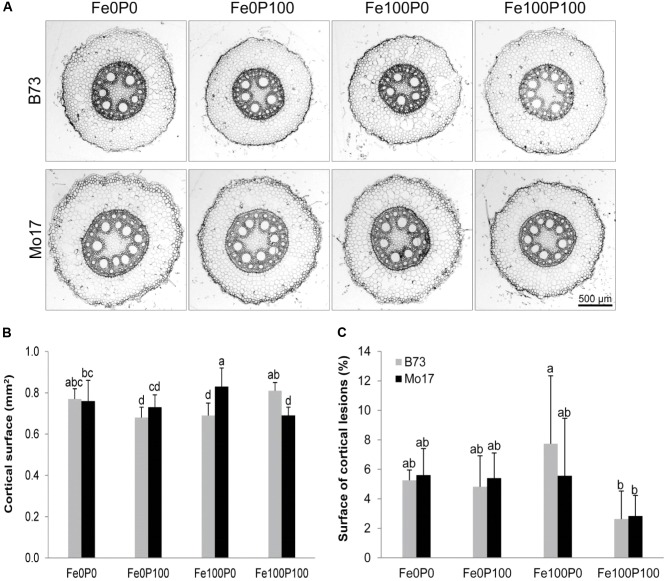
Influence of varied Fe and P nutritional regimes on root anatomy. (A) Anatomy of primary roots in cross sections, (B) cortical surface, and (C) surface of cortical lesions (expressed as proportion of lysed root tissue over the total root cross section). B73 and Mo17 plants were grown for 15 days in nutrient solution supplemented without Fe and P (Fe0P0), without Fe and with 100 μM P (Fe0P100), with 100 μM Fe and without P (Fe100P0), or with 100 μM Fe and 100 μM P (Fe100P100). Fe and P treatments were initiated after one week of preculture on full nutrient solution. Bars indicate mean values ± SD, n = 5. Different letters denote significant differences at p < 0.05.